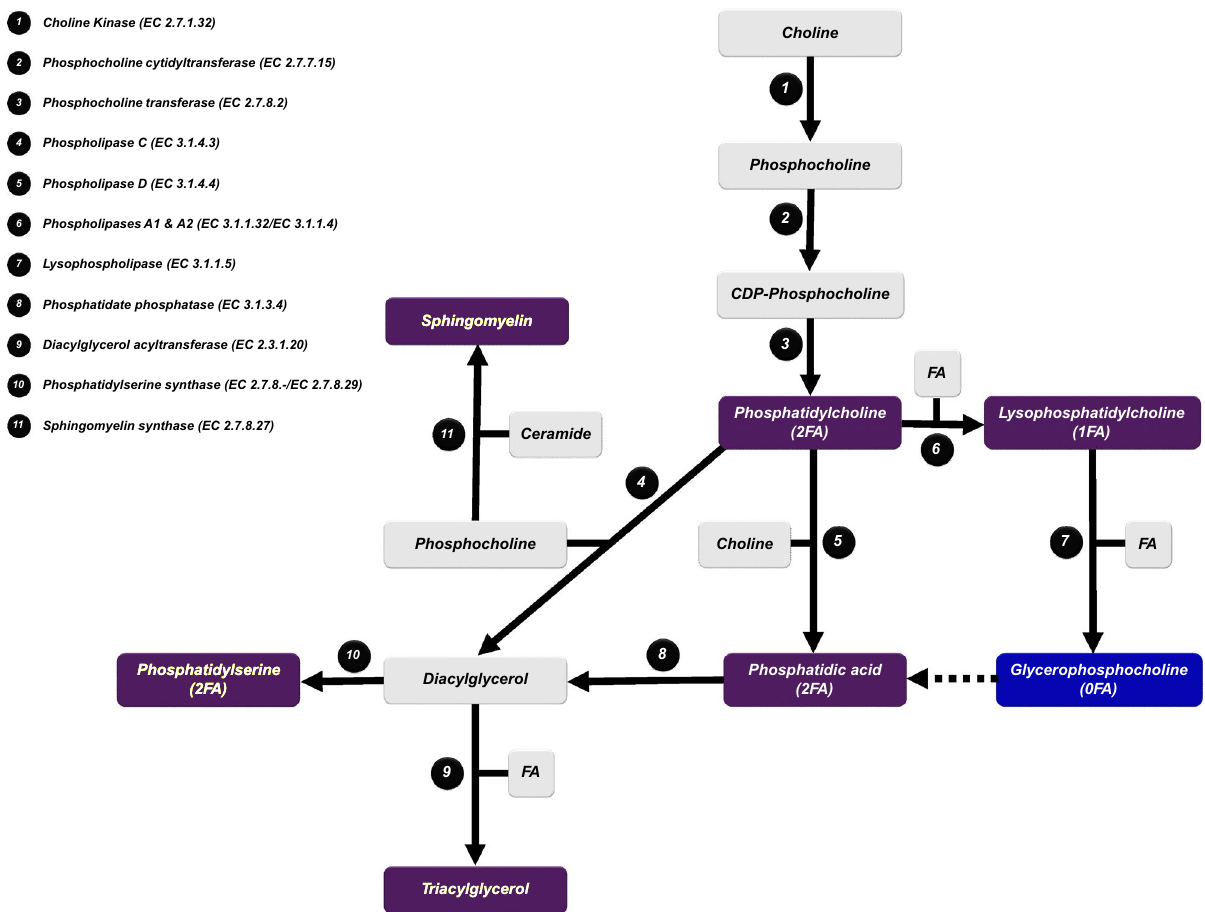
Figure 4. Phospholipid and triacylglycerol metabolism. Purple: increased metabolites in DMD. Blue: decreased metabolites in DMD. EC: Enzyme Commission number. FA: fatty